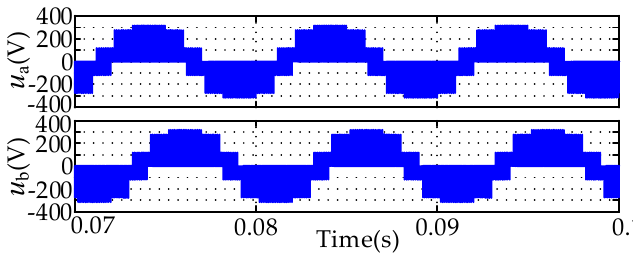
Figure 8. Output phase voltages.